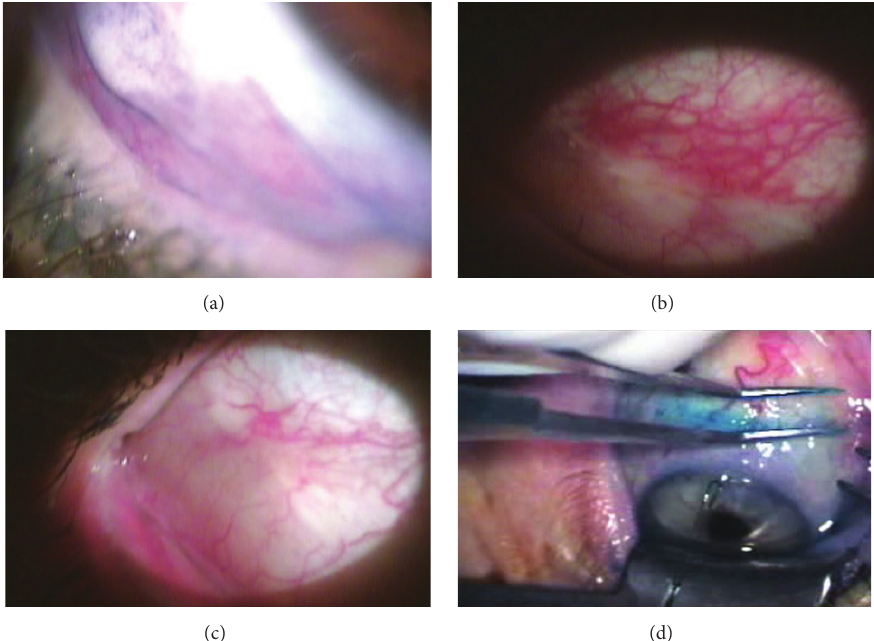
Figure 3: (a) Image showing the temporal conjunctival fold in the right eye of one patient. (b) Postoperative control at 24 hours that shows the complete reduction of the conjunctival fold with no scarring. (c) Postoperative control on day 15 that shows the complete reduction of the conjunctival fold with no scarring. (d) Image showing the application of heat with the electrocautery forceps in another